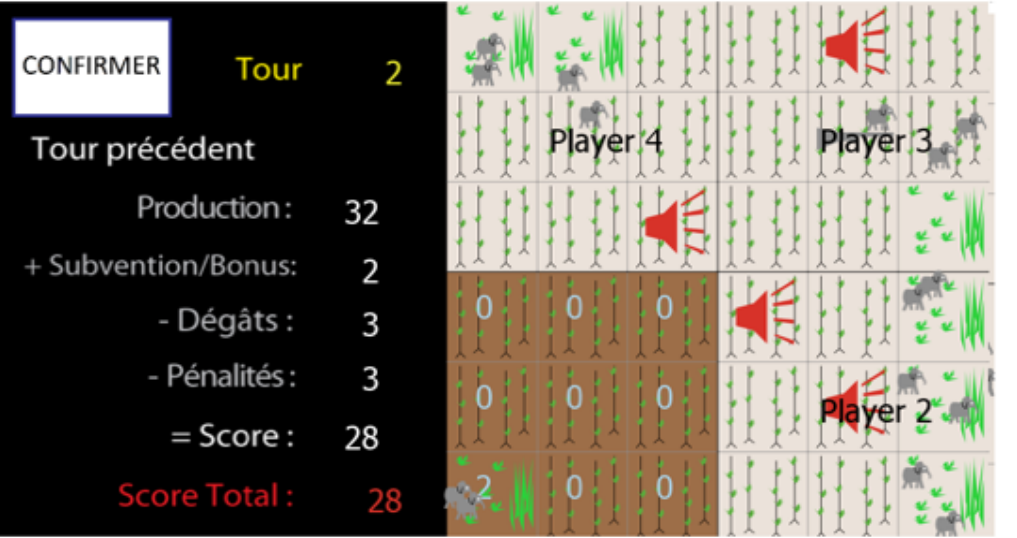
Figure 2: Bottom left corner of the landscape is active player, actions taken by other players in previous turn are